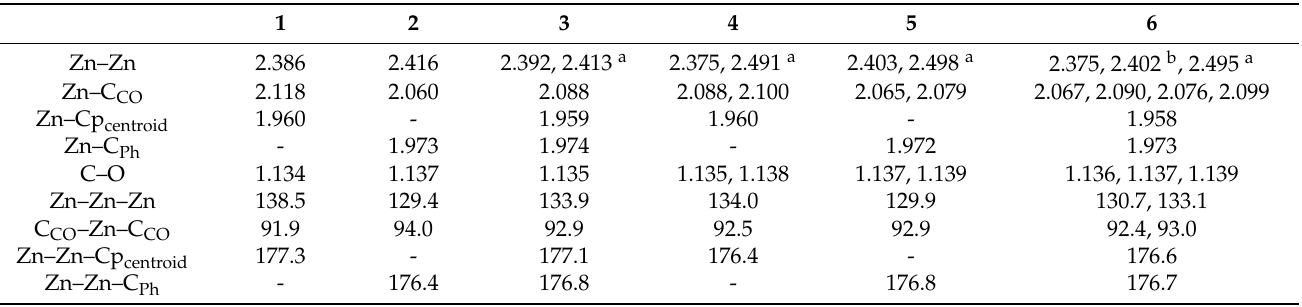
Figure 2. Optimized structures of complexes 4 – 6 , isolobally related to ethane. Table 1. Selected structural parameters (bond distances, Å, and angles, °) of complexes 1 – 6 .